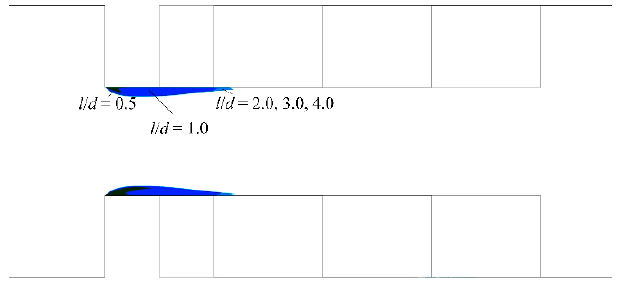
Figure 12. Vapor volume fraction on the symmetry plane vs. different l / d with α > 0.5.